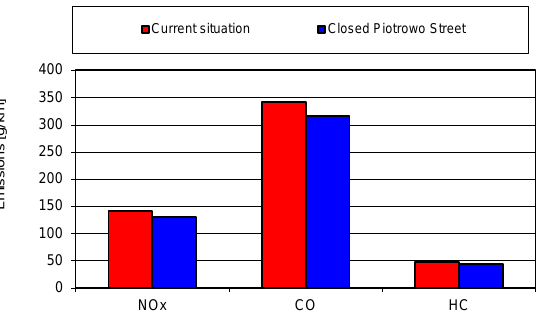
Fig. 9. Emissions of vehicles in the afternoon peak at Bolesława Krzywoustego Str.